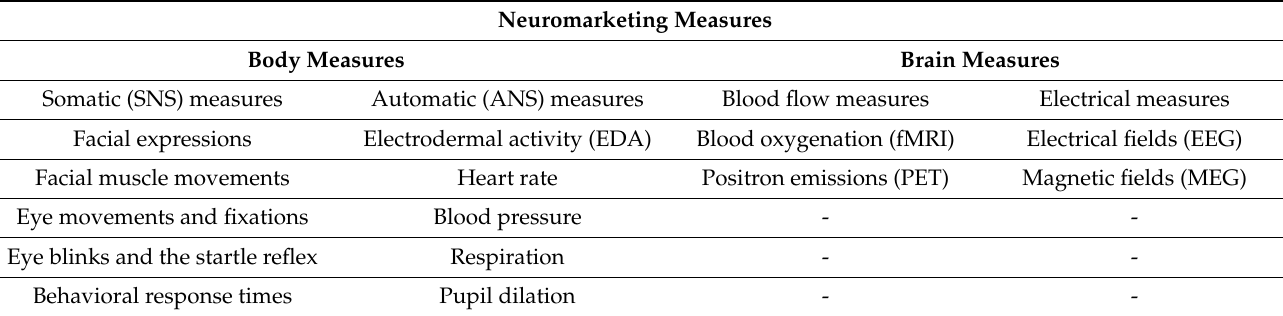
Table 1. Neuromarketing measures from the body and the